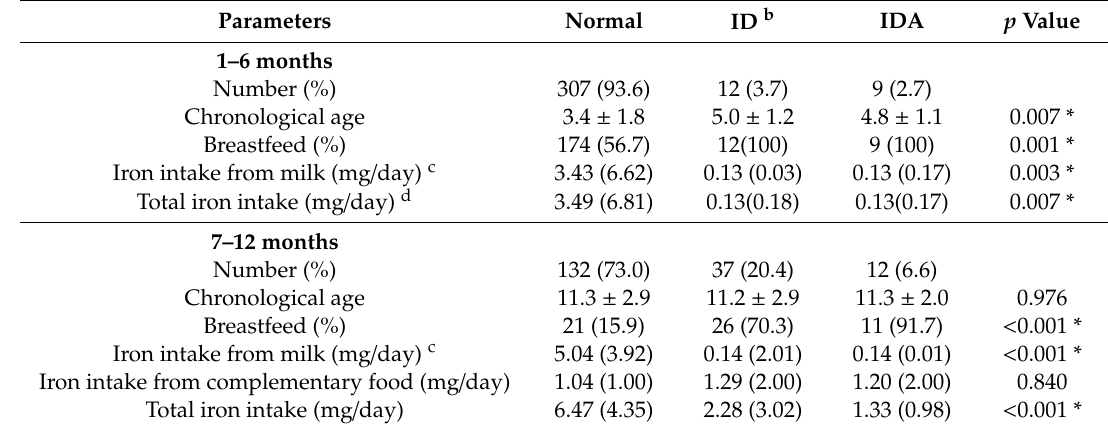
Table 3. Iron intake of infants aged 1–6 months and 7–12 months a